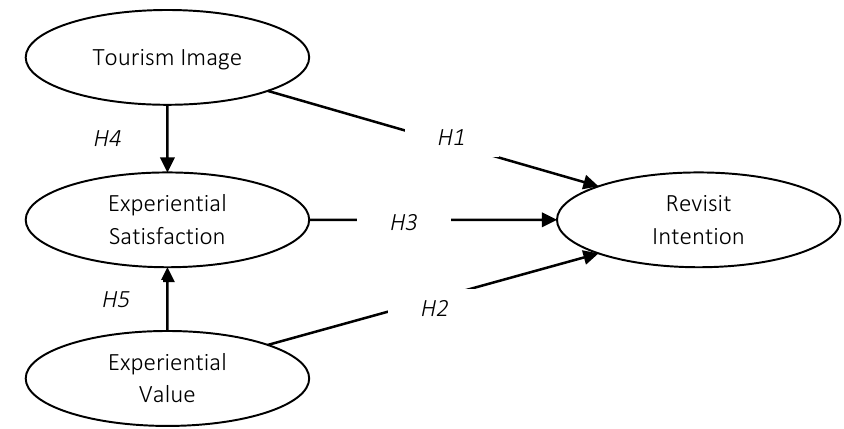
Figure 1. Conceptual